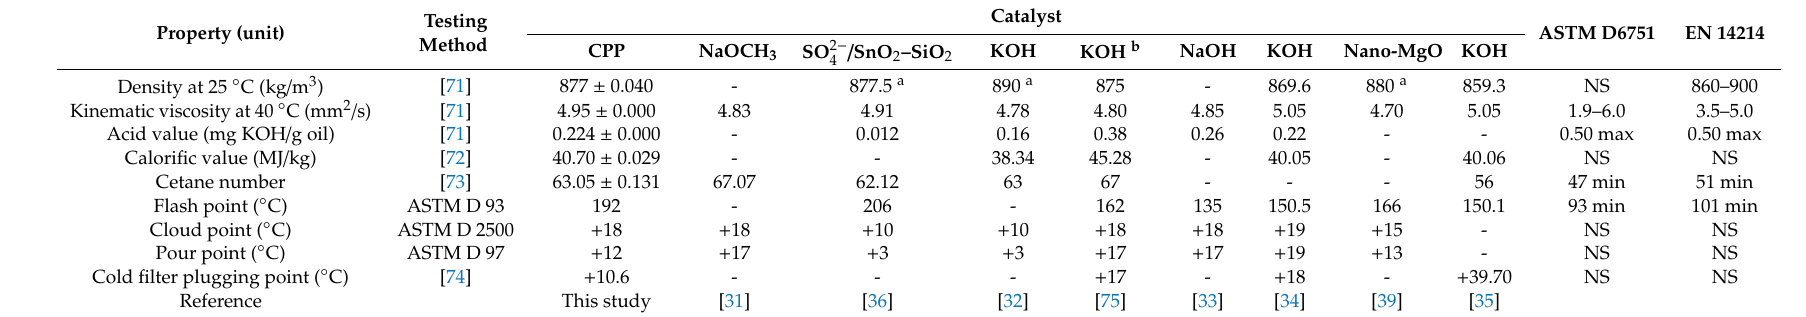
Table 5. MOOME properties based on catalyst influence with reported literature values and biodiesel